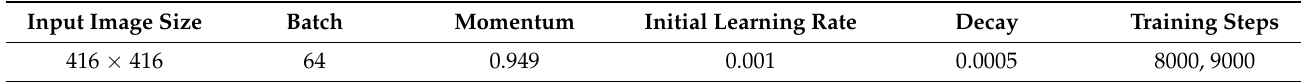
Table 3. Initialization parameters of